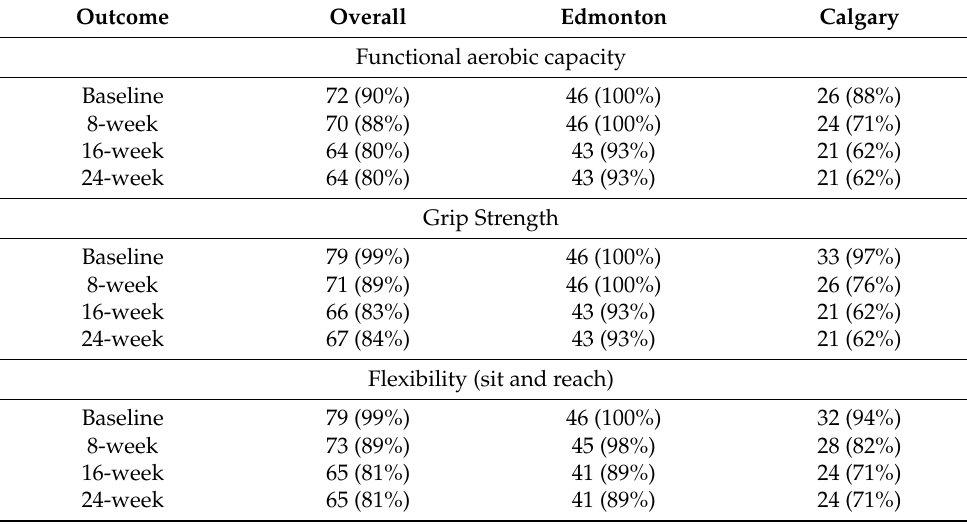
Table 2. Completion rates of individual components of the physical fitness